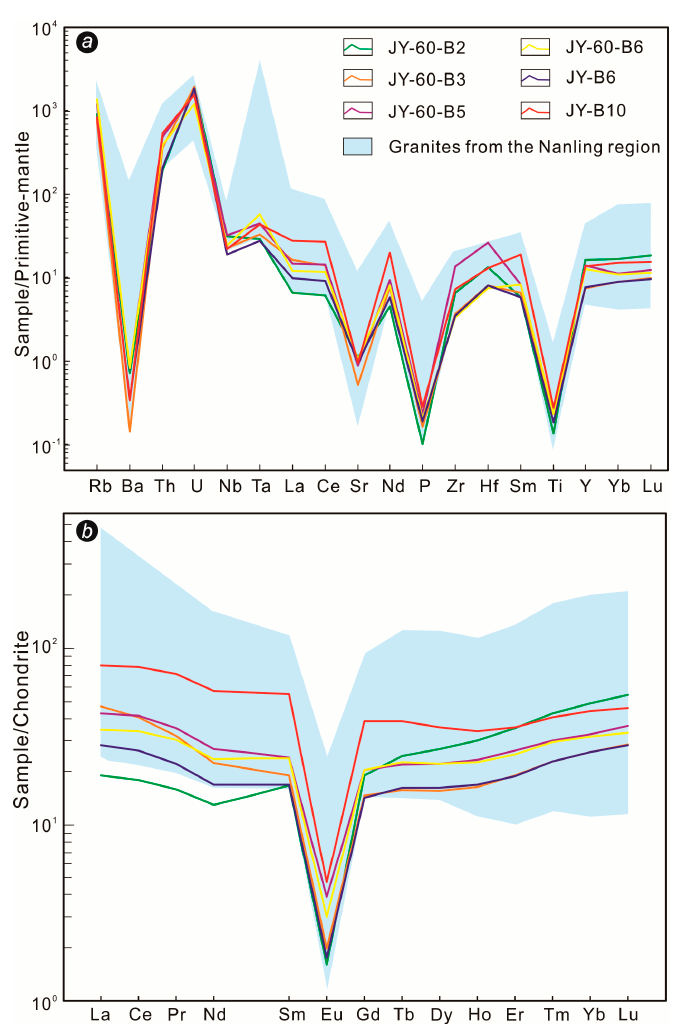
Figure 6. ( a ) Primitive mantle-normalized multiple trace element diagram, the primitive mantle normalization values are from McDonough and Sun. [63]. ( b ) Chondrite-normalized REE pattern diagram, with the chondrite normalization values adopted from Sun and McDonough [64]. Data in the shaded fields for granites in the Nanling area are taken from Zhang et al. [35], Huang et al. [23], Yu et al. [38], Zhou et al. [16], Liu et al. [43] and Gu et al. [25]. Table 1. Bulk rock major (wt.%) and trace (ppm) element compositions of Junye granites. Sample No.